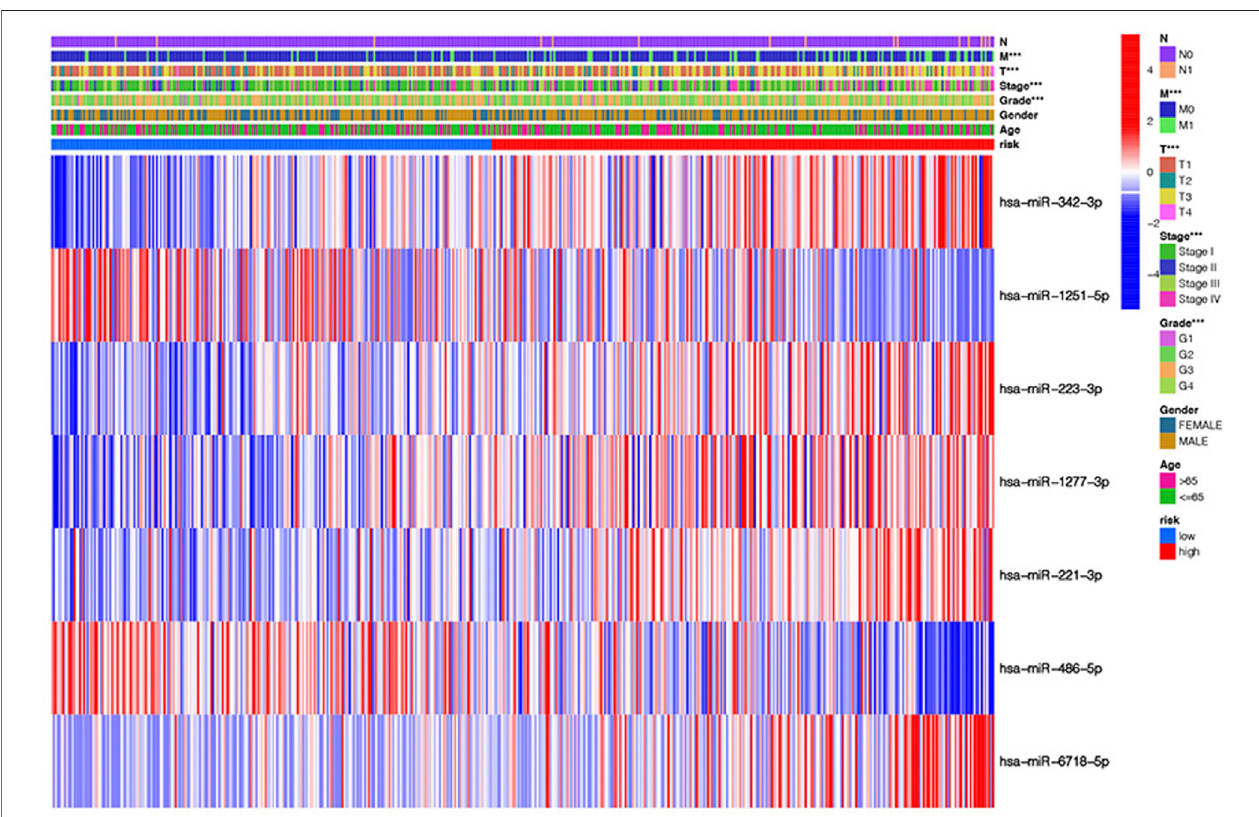
FIGURE 5 | The heatmap shows the clinical characteristics and risk scoring of every KIRC